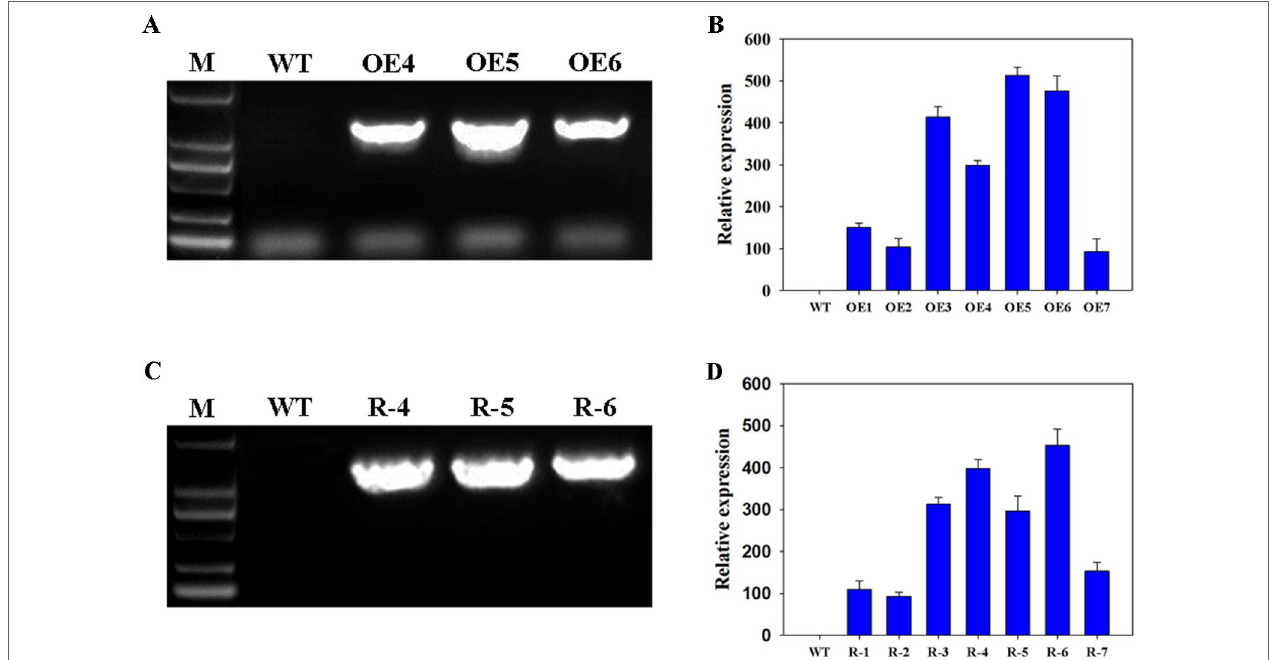
FIGURE 1 | Confirmation of TaFBA1 transgenic lines by genomic PCR and real-time PCR. Genomic PCR (A , C) and qRT-PCR (B , D) of TaFBA1 overexpression in Arabidopsis thaliana lines (A , B) and TaFBA1 homozygous gene mutant recovery lines (C , D)